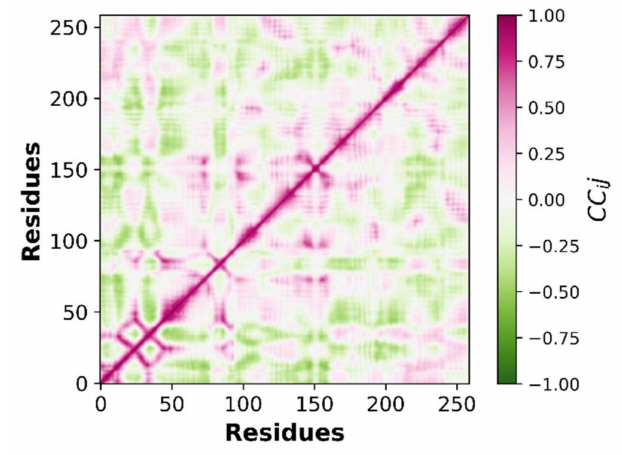
Figure 17. Pearson correlation graph for NEK7 variables.